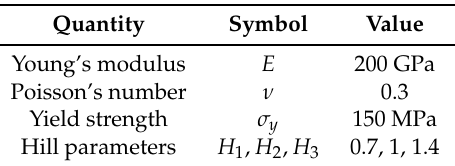
Table 1. Elastic and plastic material parameters defining the reference material with Hill-like anisotropy in its plastic flow behavior. For simplicity, isotropic elastic behavior and ideal plasticity without work hardening are assumed in this